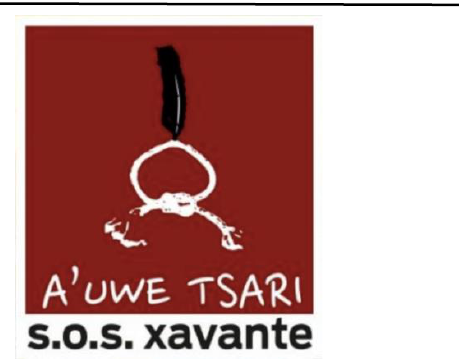
Figure 1: Xavante Indians campaign against the coronavirus pandemic. “A´uwe tsari,” which translates as “help the Xavante